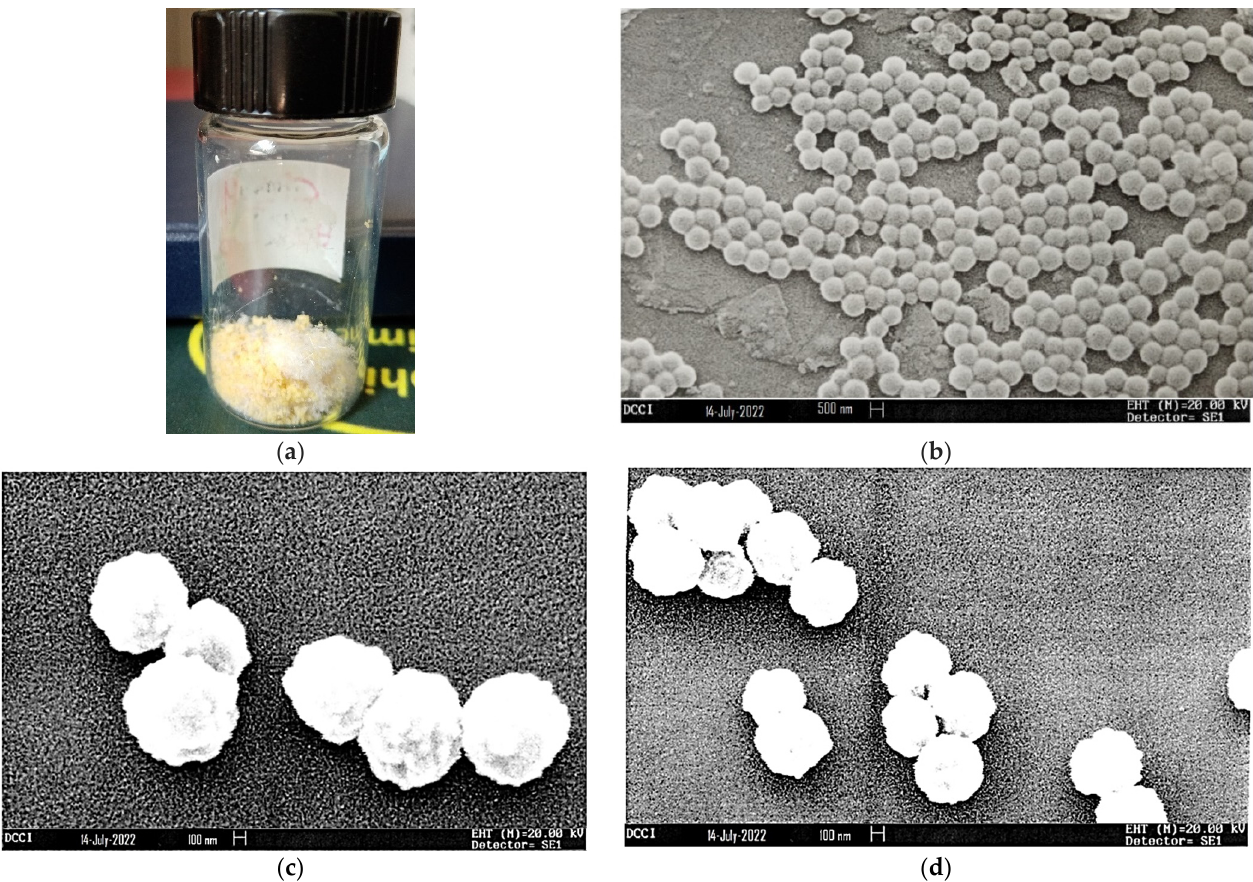
Figure 5. Lyophilized CP1_1.1-Hgel ( a ); representative SEM micrographs of a freeze-dried sample of CP1_1.1-Hgel ( b – d ).